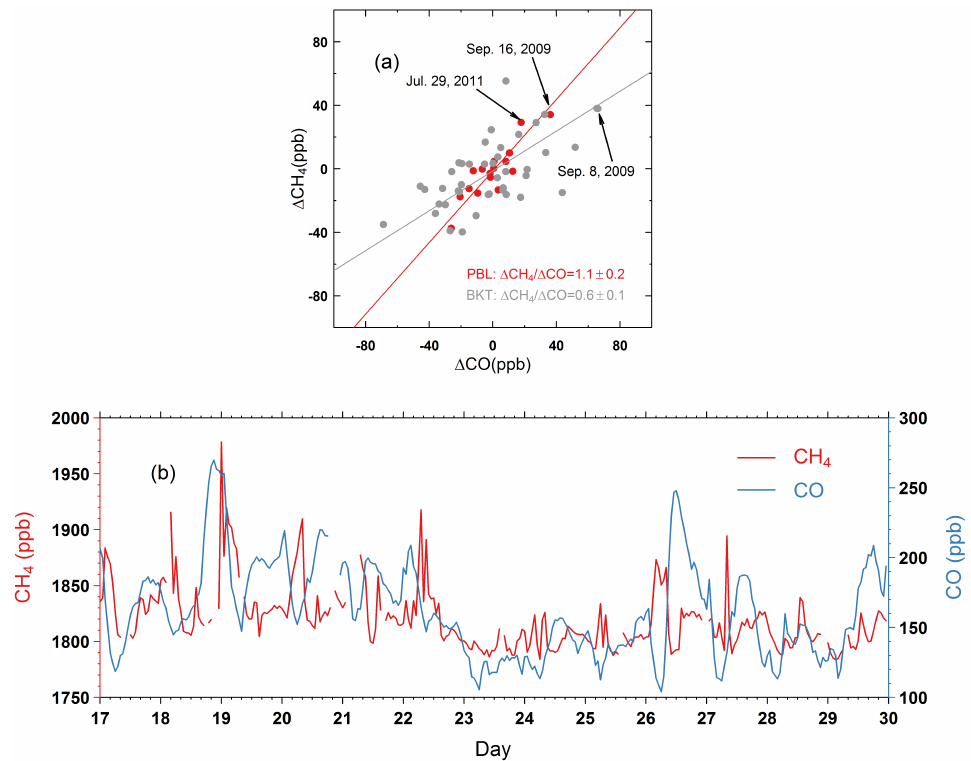
Figure 17. (a) The relationship between (cid:49) CH 4 and (cid:49) CO at PBL (colored by red) and BKT (colored by grey) during July–September (JAS) over the period of 2007–2011. (cid:49) CH 4 and (cid:49) CO are estimated as residuals from smoothed curves. The (cid:49) CH 4 /(cid:49) CO ratio is the slope of the fitting line from orthogonal distance regression (ODR), with the SD calculated from 1000 bootstrap replications. Two abnormal events at PBL are labeled, with enhancements of CH 4 and CO on 16 September 2009 and 29 July 2011, respectively. Enhancements of CH 4 and CO are also observed at BKT on 8 September 2009. (b) Hourly CH 4 and CO measurements at BKT in July 2011. Enhancements of CH 4 and CO are observed during 17–21 July